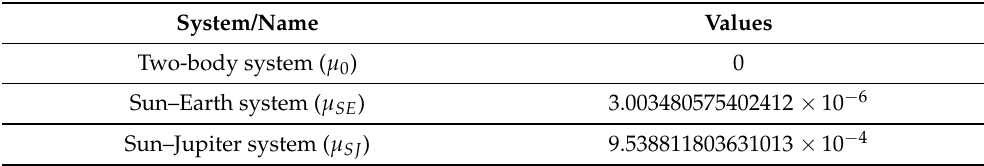
Table 1. The mass parameter values of the unperturbed two-body system ( µ 0 ), the Sun–Earth system ( µ SE ), and the Sun–Jupiter ( µ SJ )